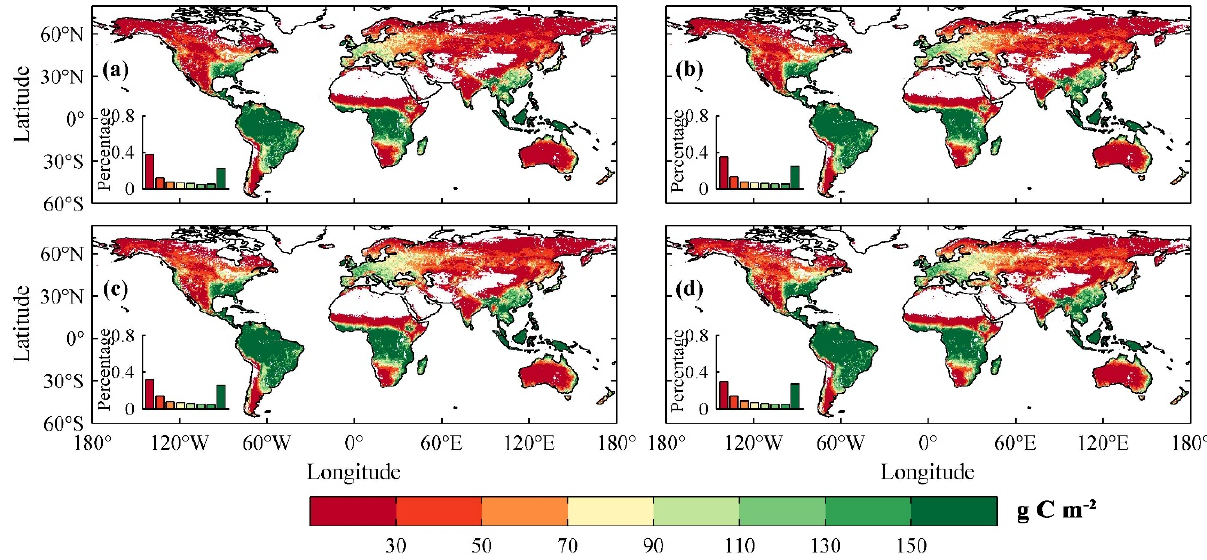
Figure 7. Spatial distribution of global LUE GPP values at 10th ( a ), 20th ( b ), 30th ( c ) and 40th percentiles ( d ) during March- May.